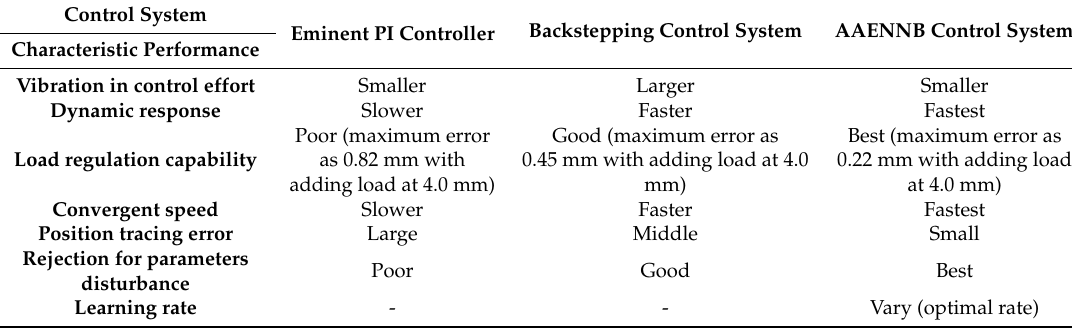
Table 2. Characteristic performance comparisons of control